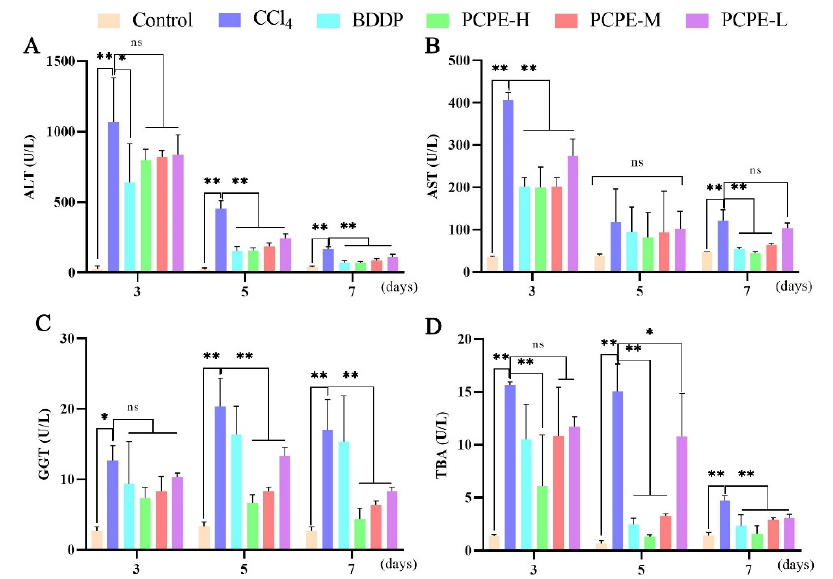
Figure 3. PCPE effects on liver function enzymes in CCl 4 ‐ induced ALI dogs. ( A ) ALT, ( B ) AST, ( C ) GGT, ( D ) TBA. Data represented as Means ± SD. *, **, and ns indicates p < 0.05, p < 0.01, non ‐ signif ‐ icant, respectively.